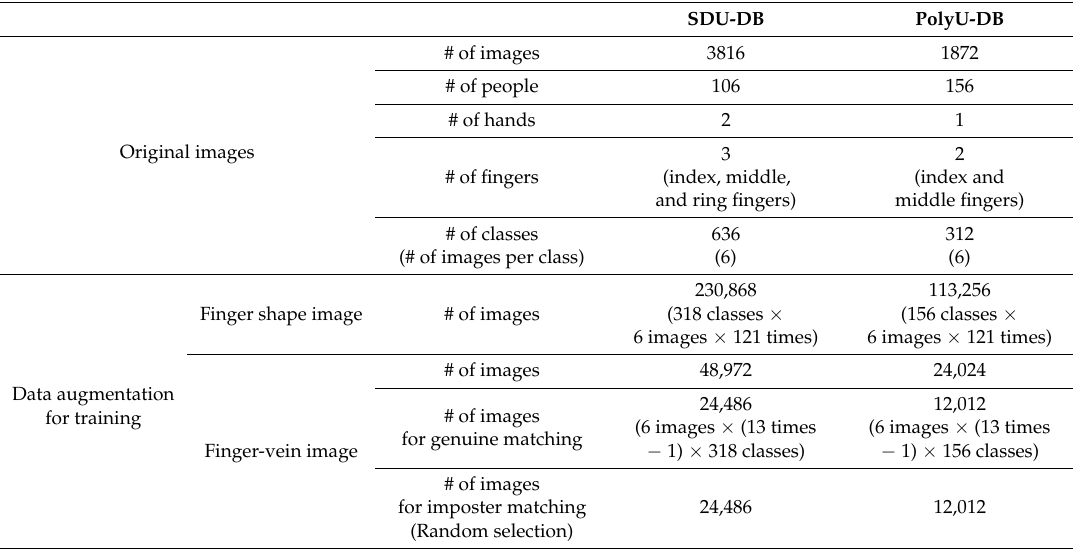
Table 3. Descriptions of two databases used in our